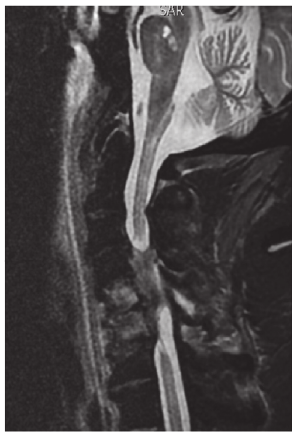
Figure 1: Septic involvement of cervical spine and spinal cord.